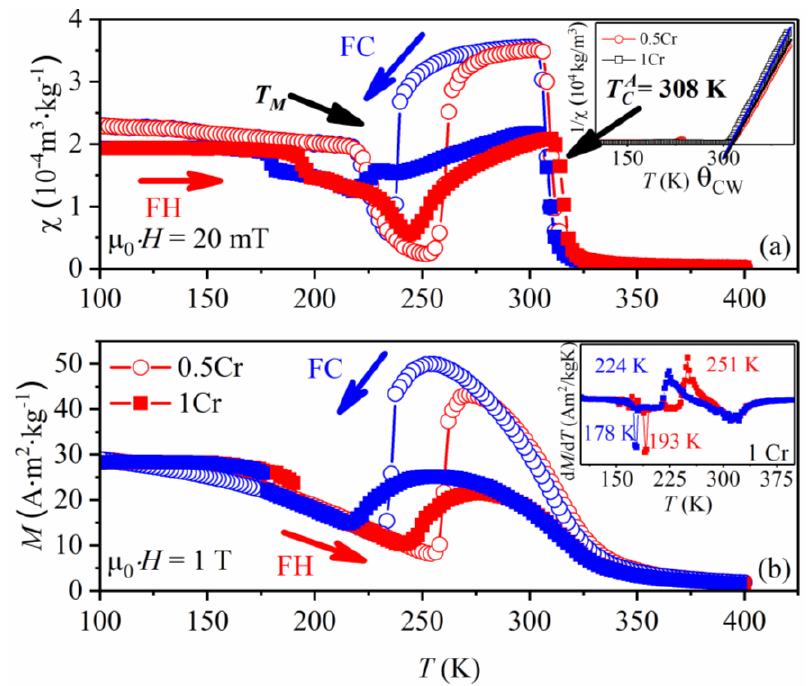
Figure 3. Temperature dependence of magnetic susceptibility ( χ ) and magnetisation ( M ) under a magnetic field of 20 mT ( a ) and 1 T ( b ) on cooling (FC) and on heating (FH) for the 0.5 Cr and 1 Cr alloys. The inset in Figure 3a shows the reciprocal of the magnetic susceptibility vs. temperature for the 0.5 Cr and 1 Cr alloys, whereas the inset in Figure 3b shows the d M /d T (FC—red, FH—blue) vs. temperature for the 1 Cr sample.